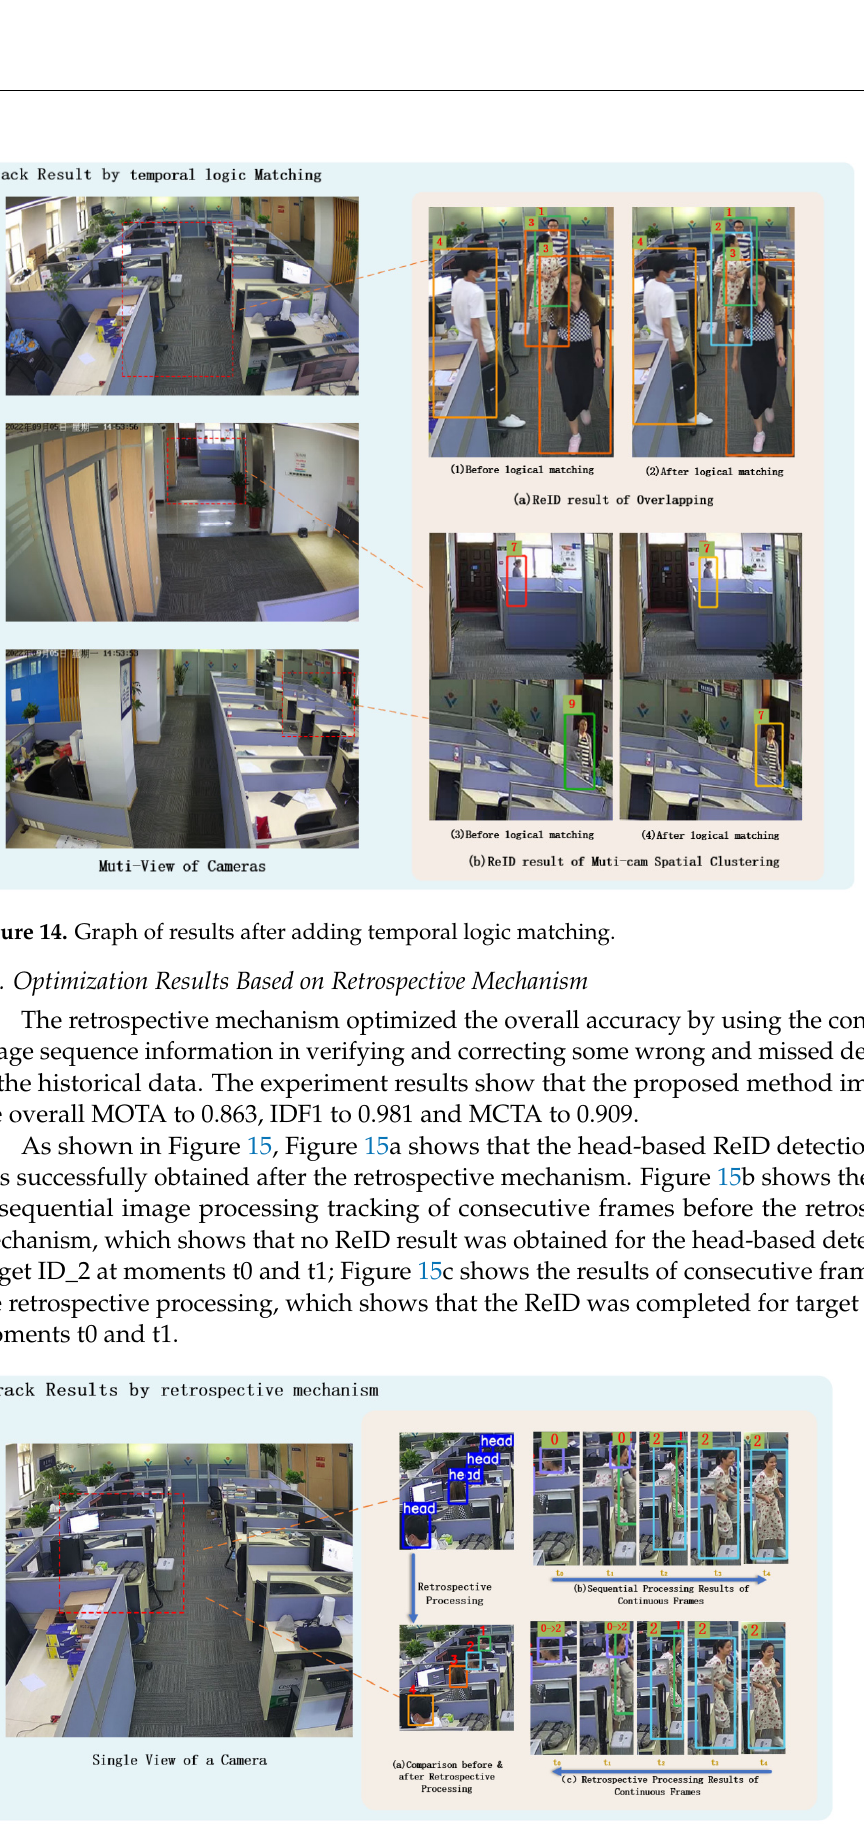
16 of 19 Figure 13. Graph of results after adding multi-dimensional dynamic feature matching. 5.2. Optimization Results Based on Temporal Logic Matching Method After the space–time logic matching, the overall MOTA improved to 0.860, while the IDF1 increased to 0.948 and MCTA to 0.878, as detailed in Figure 11. Under the global raster semantic map, with spatial logic matching, the detection accuracy of the overlap- ping field of view area is improved. The spatial position association between the body and head detection frames was introduced so that when the body detection frame was lost due to the target’s intersection, occlusion, or scale change, the head detection could still main- tain the continuous tracking and ID of the target.